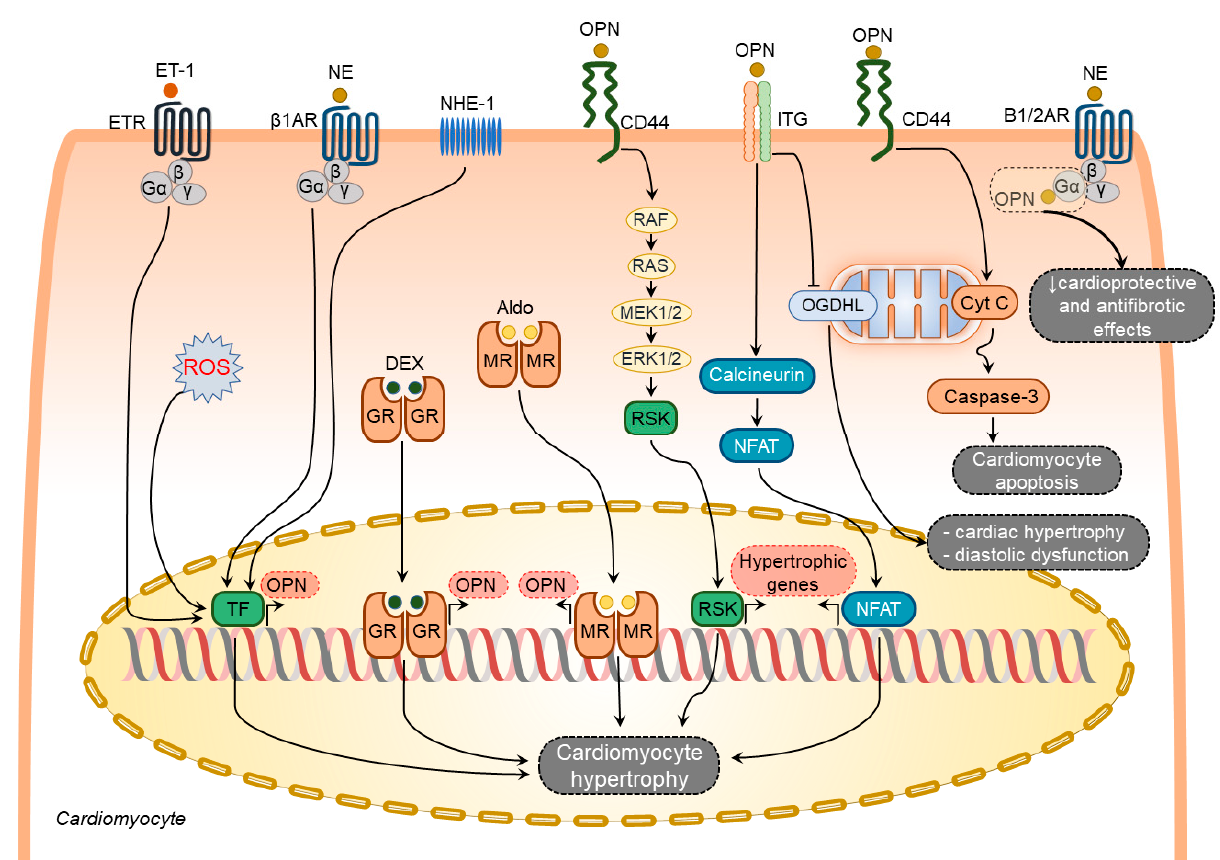
Figure 2. Osteopontin signaling in cardiomyocytes. Various factors such as endothelin-1 (ET-1), norepinephrine (NE), sodium-hydrogen exchanger isoform-1 (NHE-1), reactive oxygen species (ROS), dexamethasone (DEX), and aldosterone (Aldo) upregulate osteopontin (OPN) in cardiomyocytes. In turn, osteopontin regulates several processes in cardiomyocytes via modulating certain signaling pathways. These pathways include induction of hypertrophic genes expression via integrin- and CD44-mediated signaling pathways, cardiomyocyte hypertrophy and diastolic dysfunction via blocking mitochondrial protein oxoglutarate dehydrogenase-like (OGDHL), and cardiomyocyte apoptosis via mitochondrial apoptosis signaling pathway, attenuation of the beneficial effects of adrenergic signaling by directly binding and blocking G- α subunit of the adrenergic receptors. The overall effect of osteopontin signaling in cardiomyocytes results in cardiomyocyte hypertrophy, cardiomyocyte apoptosis, and cardiomyocyte mitochondrial dysfunction. Endothelin-1 and NE-mediated osteopontin upregulation in rat cardiomyocytes co- incide with the induction of atrial natriuretic peptide expression [58], suggesting an active involvement of osteopontin in hypertrophic responses of the cardiomyocytes. Cardiomy- ocyte hypertrophy, LV dilatation, and dysfunction caused by Na + /H + exchanger isoform 1 (NHE1) overexpression in mice were associated with osteopontin upregulation and oste- opontin-CD44 mediated activation of p90-ribosomal S6 kinase signaling pathways [76]. All these pathological changes were reversed in double transgenic mice expressing active NHE1 and osteopontin knockout [76]. Hypertrophic effects of osteopontin on cardiomy- ocytes can also be mediated through the calcineurin/NFAT pathway [77,78]. In addition, osteopontin can diminish the cardioprotective and antifibrotic effects of β 1- and β 2-adre- noceptors signaling pathways by direct binding to their G α s subunits [73]. Several studies have demonstrated an association of increased osteopontin expres- sion with enhanced cardiomyocyte apoptosis in different HF models [29,67,70]. Cardio- myocyte-specific osteopontin overexpression in mice was associated with decreased LV function and increased cardiomyocyte apoptosis [79]. In support of these findings, treat-